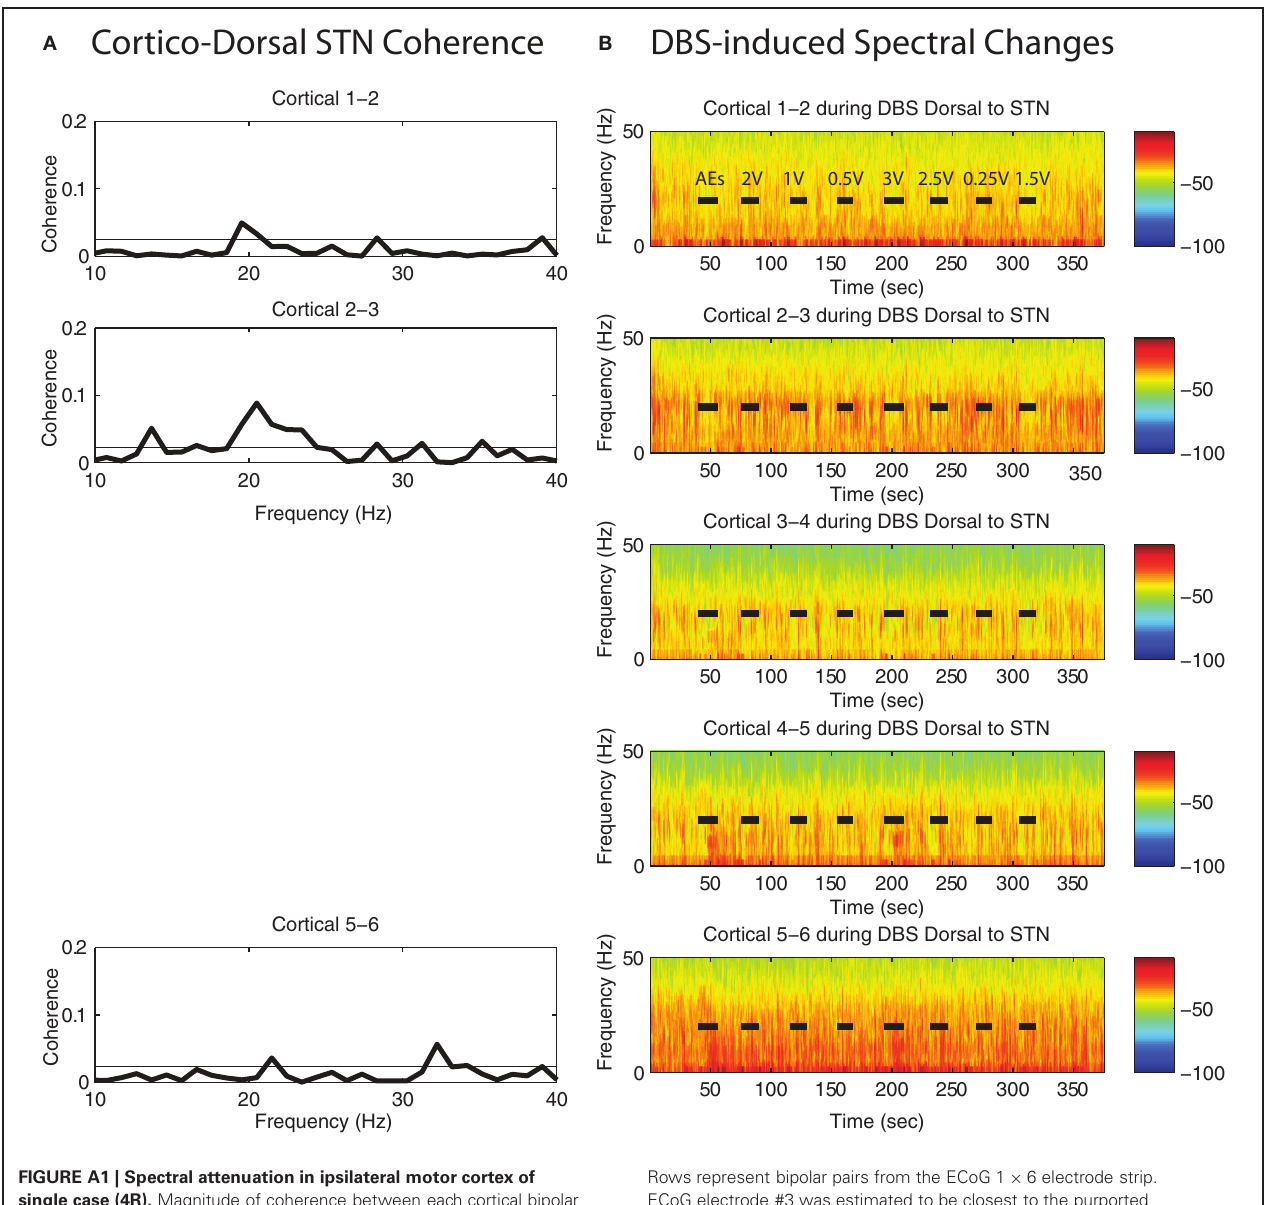
Rows represent bipolar pairs from the ECoG 1 × 6 electrode strip. ECoG electrode #3 was estimated to be closest to the purported efferent projection site of the hyperdirect pathway. Coherence computation missing in cases where cortical channel #4 was contaminated by